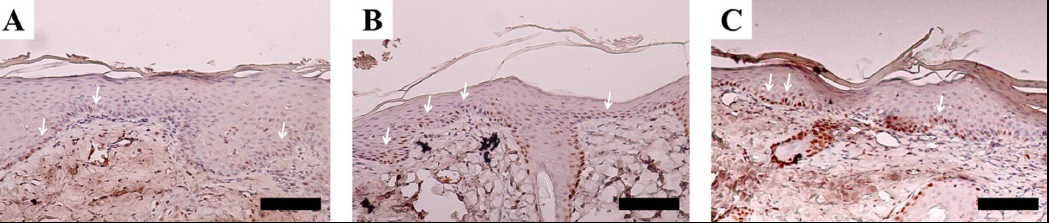
Figure 7. At 7 days, PCNA expression was observed in the tissue covering the infected region. Medical gauze ( A ), SF nanomatrix ( B ), and Medifoam ® ( C ) (scale: 50 µm). Reprinted with permission from reference [157].